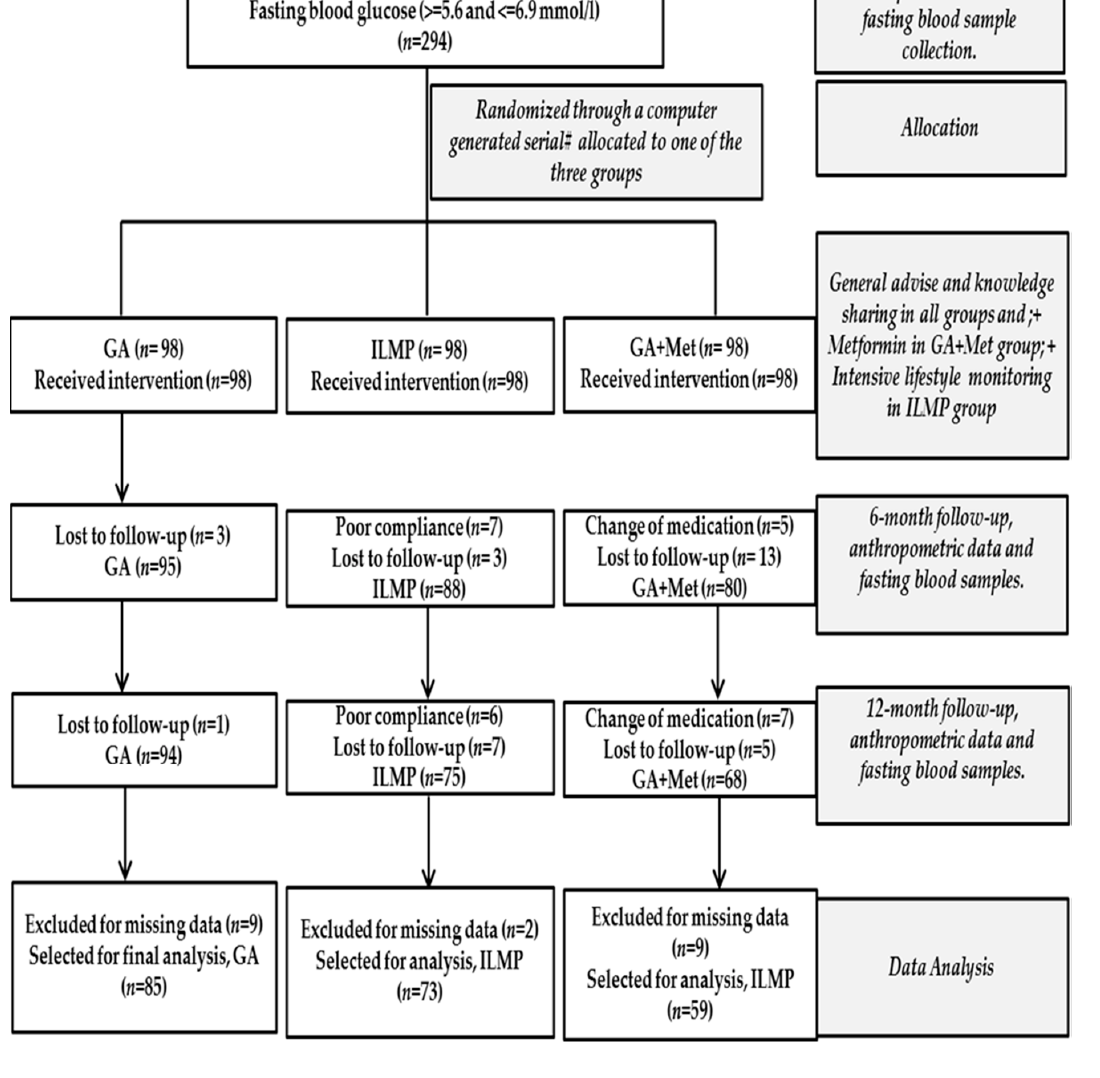
Figure 1. Flow chart detailing the participation of subjects and their allocation to treatment groups.